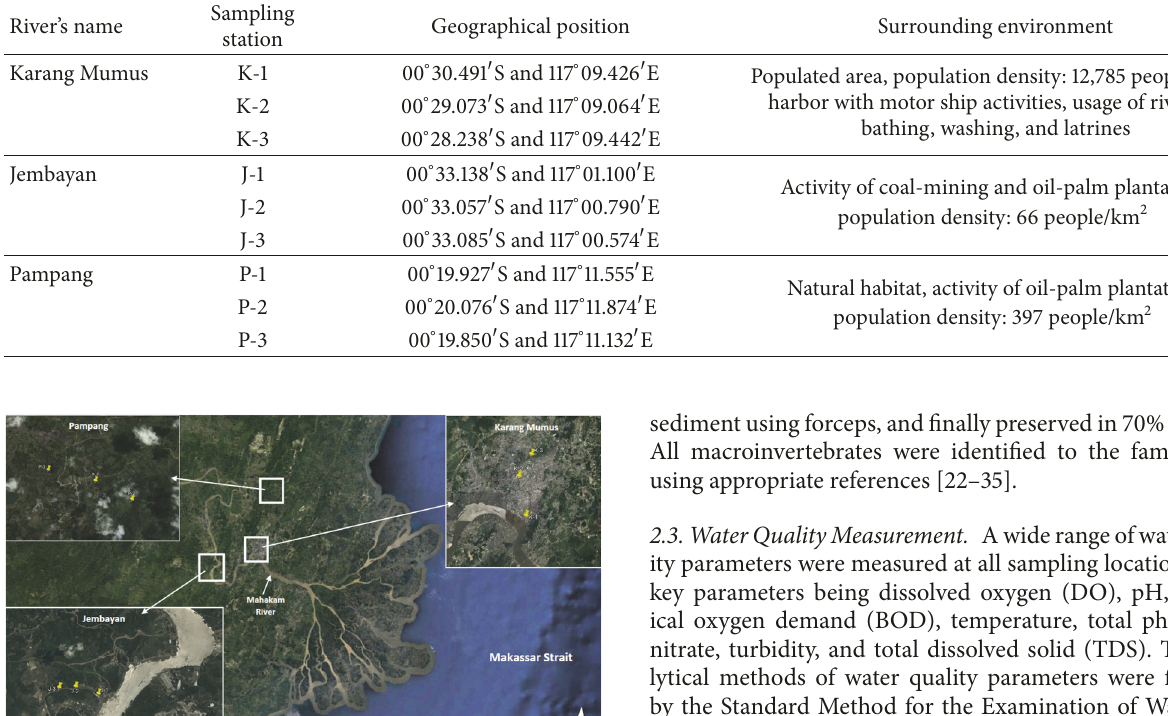
Table 1: Detailed information of sampling stations.